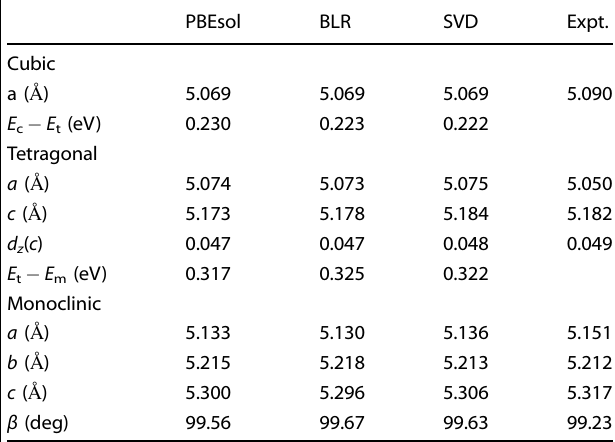
Table 2. Structural parameters for all three phases of ZrO 2 and energy differences between